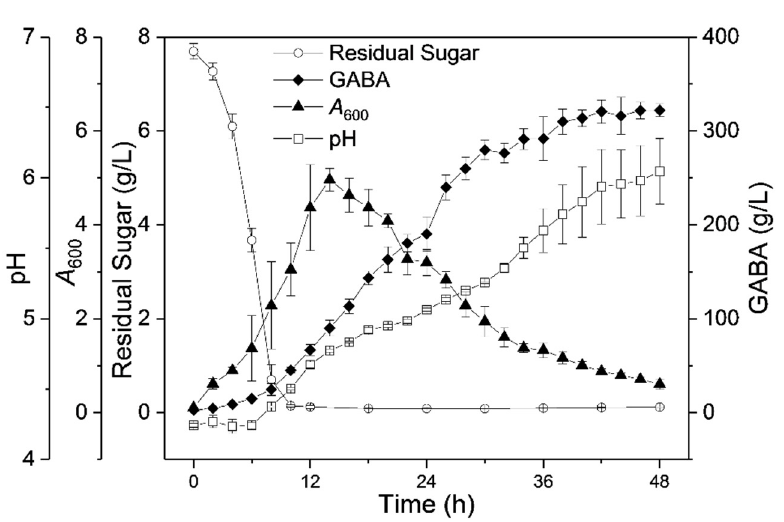
Figure 8. pH auto-sustain-based GABA fermentation in a 10 L fermenter. The fermentation experi- ment was conducted at 30.0 ◦ C and 50 rpm. Each liter of fermentation medium was supplemented with 650 g solid powder L-glutamic acid. Cell growth was expressed as A 600 . Vertical bars represent standard deviations of means ( n = 3). The 48 h GABA concentration was 321.9 ± 6.7 g/L. GABA, gamma-aminobutyric acid; A 600 , absorbance at 600 nm.